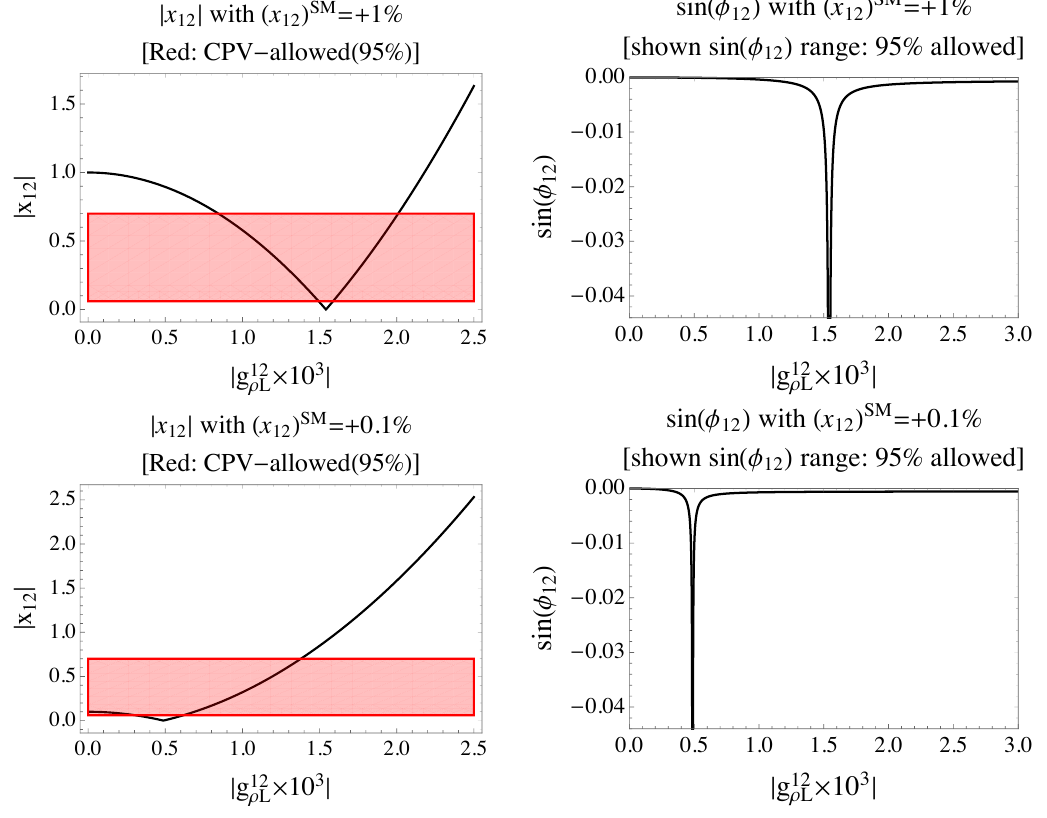
Figure 4 . Curves of j x 12 j and sin (cid:30) 12 as functions of j g 12 (upper panels) and x SM = +0 : 1% (lower panels). Note that the enhancements of sin (cid:30) 12 around j g 12 j (cid:24) 1 : 5 (cid:2) 10 (cid:0) 3 (for x SM = +1% ) and (cid:24) 0 : 5 (cid:2) 10 (cid:0) 3 (for x SM = +0 : 1% ) arises due to the vanishing (cid:26)L Re[ x 12 ] by the cancellation between the CFV and the SM